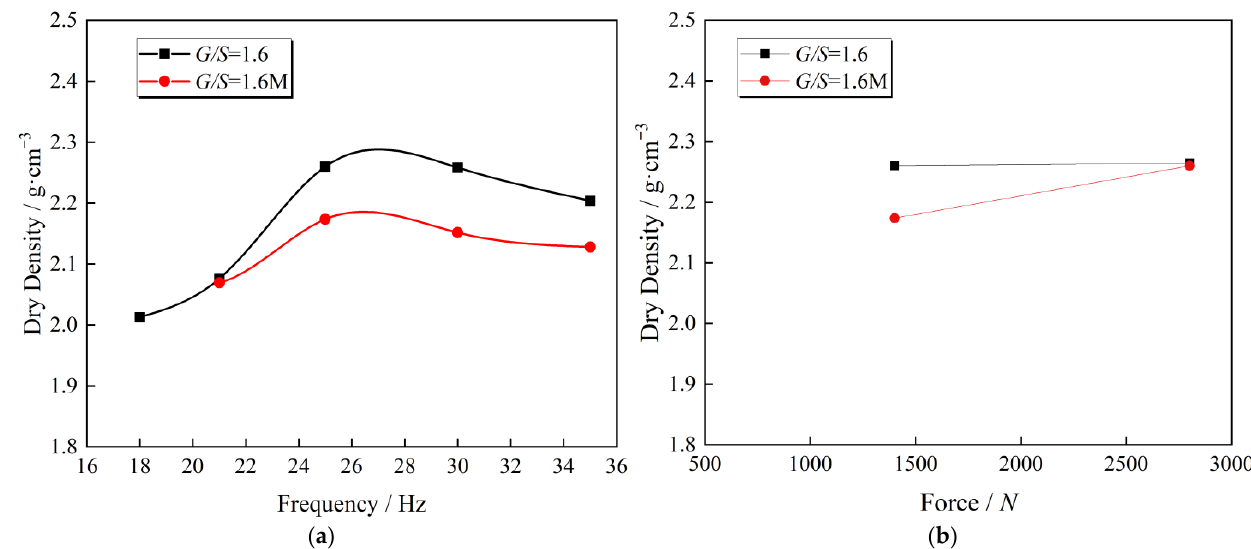
Figure 10. Comparison of achieved dry density after vibratory compaction between G / S = 1.6 and G / S = 1.6 M at ( a ) different vibratory frequency levels and at ( b ) different vibratory force levels.